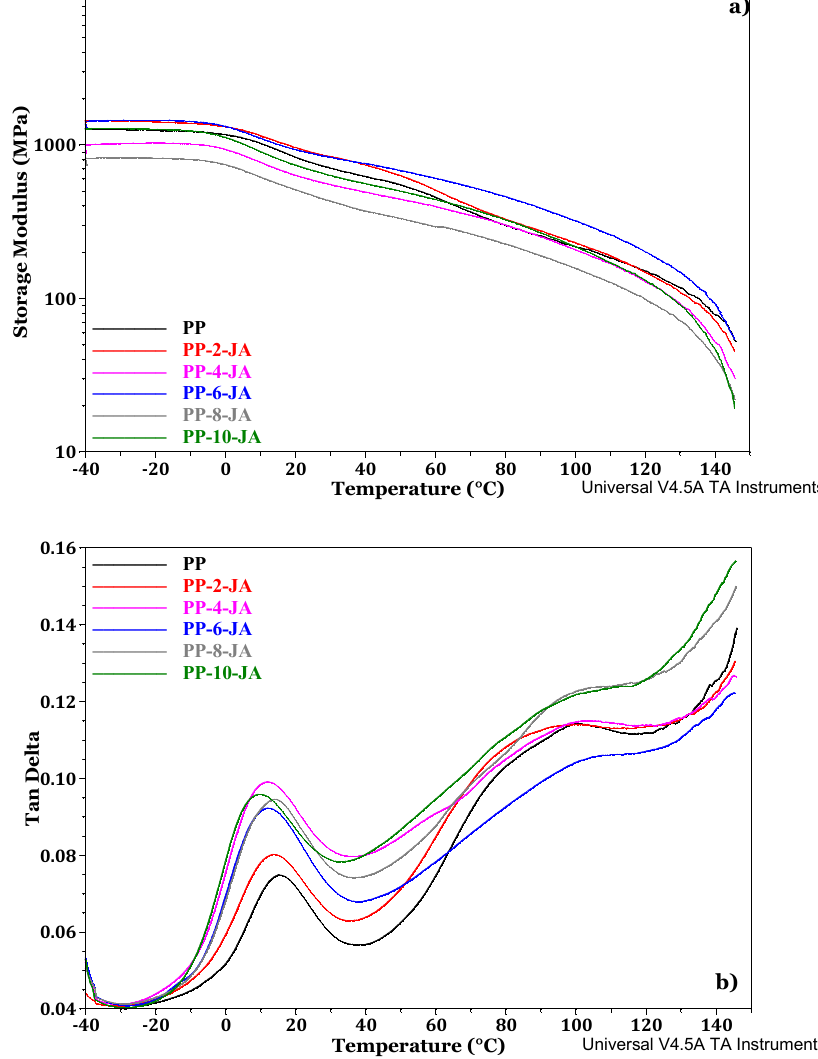
Figure 5. DMA thermogram for PP and PP-JA composites. ( a ) Storage modulus versus temperature, and ( b )tan δ versus temperature.